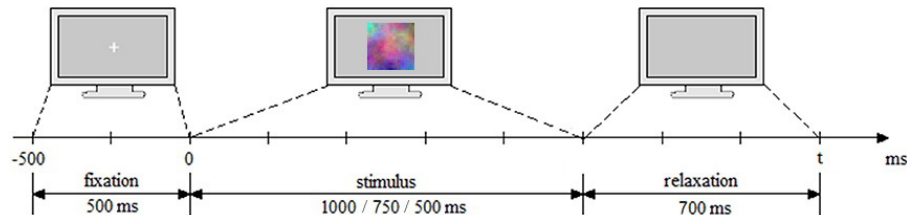
Figure 4. Experimental paradigm and timing: fixation period of 500 ms, trial of 1000/750/500 ms for blocks, and relaxation period of 700